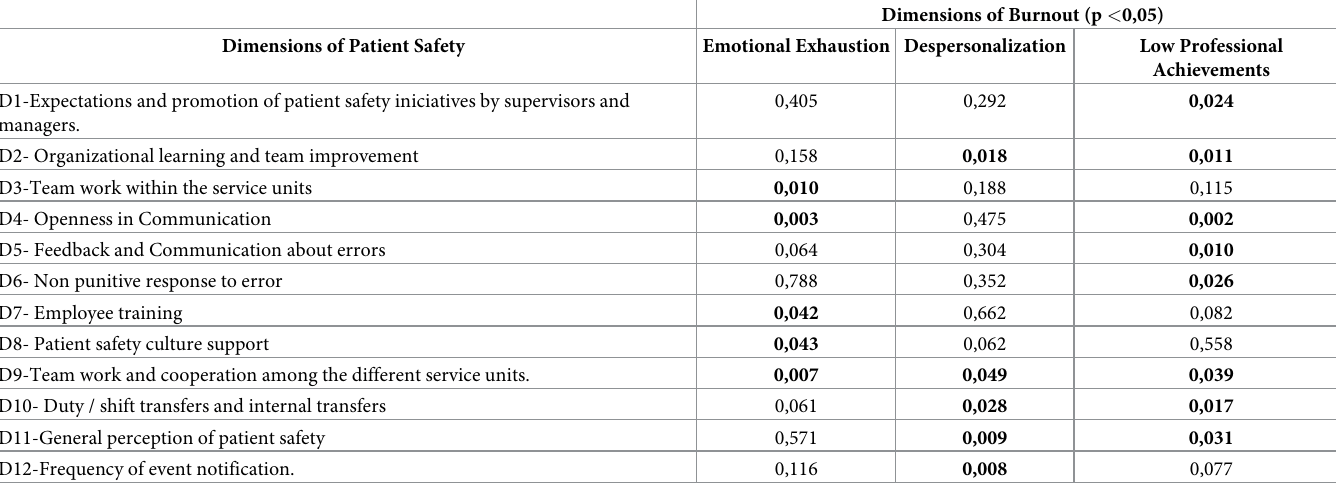
Table 5. Correlation between dimensions of patient safety culture and burnout. Ceara´, Brazil,